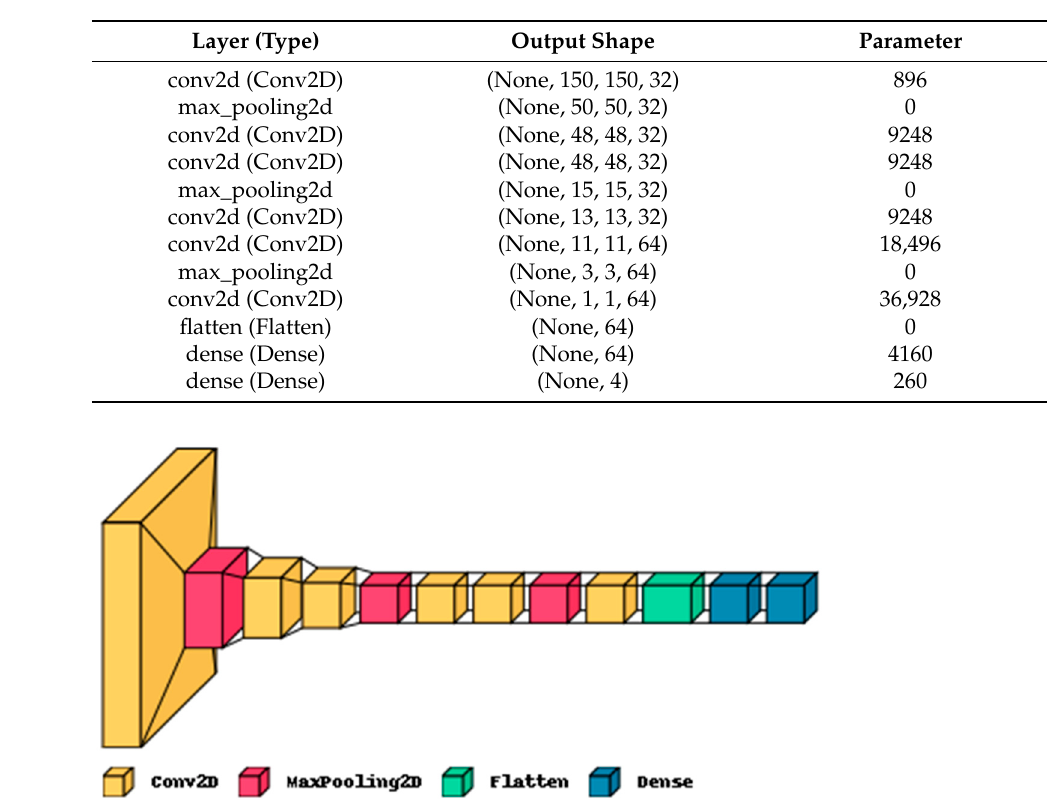
Figure 10. Comparison flow chart with the existing classifier. Table 4. The details of the CNN model.